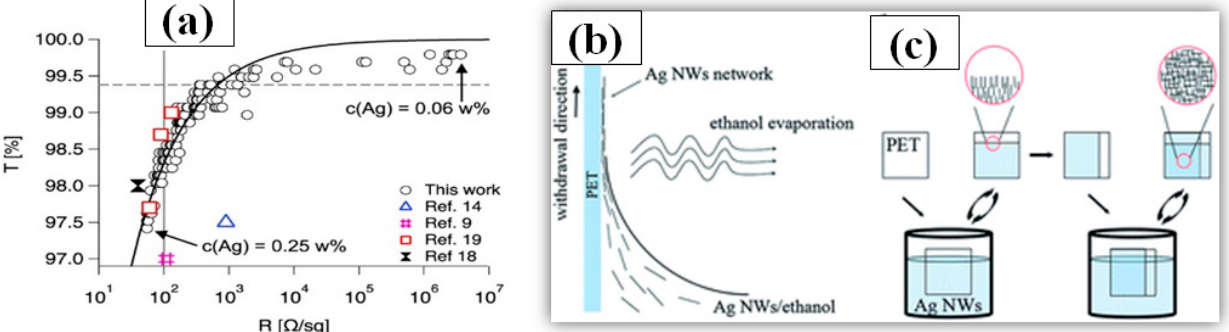
rotating the substrate in perpendicular direction (adapted from [193] with permission from Royal Society of Chemistry,